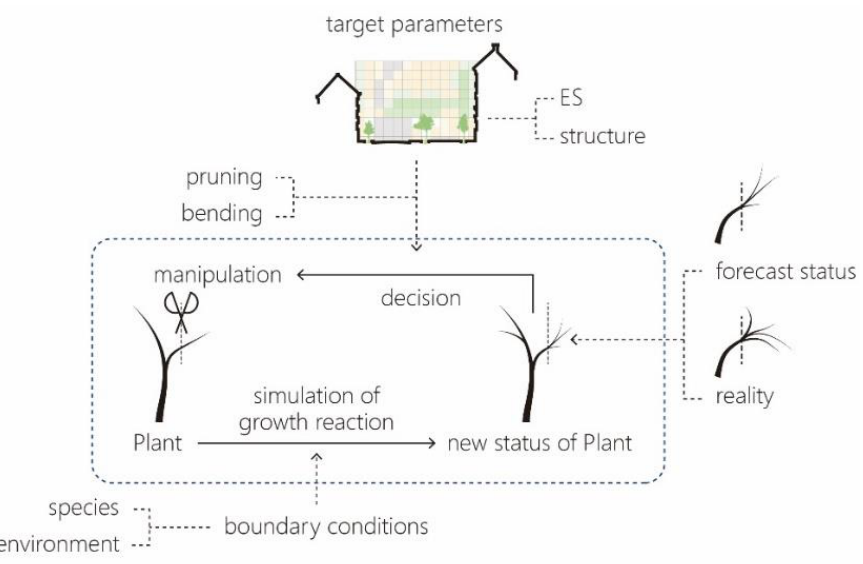
Figure 8. A proposed feedback structure about the iterative survey-simulation-manipulation proce- dure for designing with trees.